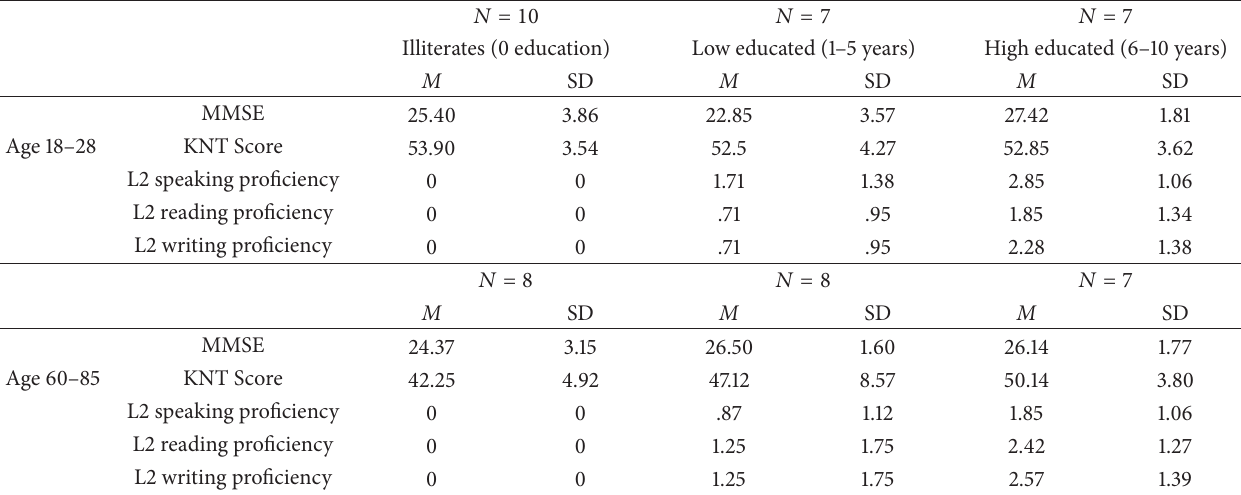
Table 1: Participant